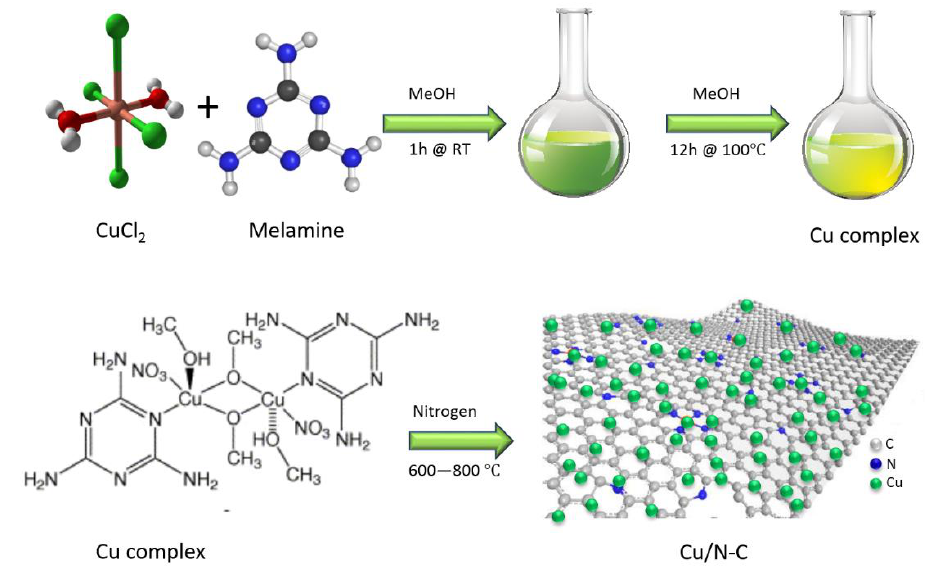
Figure 2. The synthesis schematic of copper-decorated nitrogen-doped carbon nanosheets.